Question: Which visualization type does this figure use?
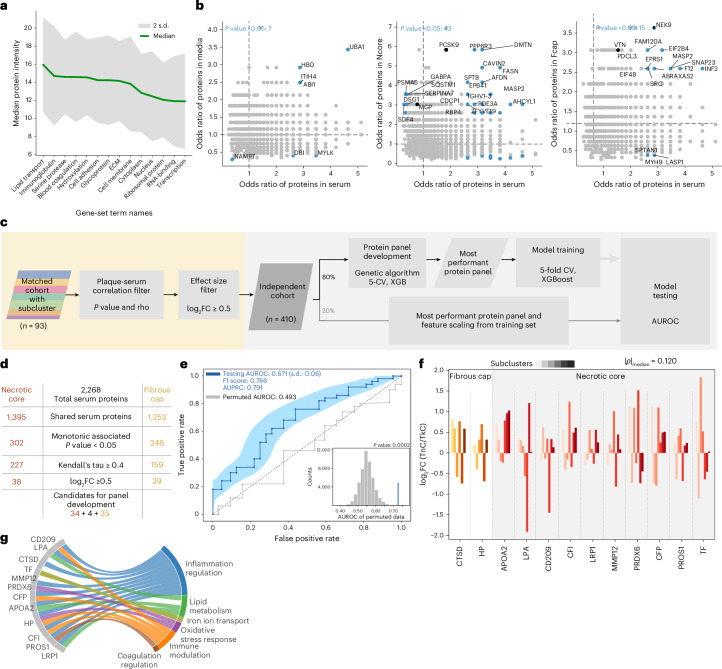
Answer: line